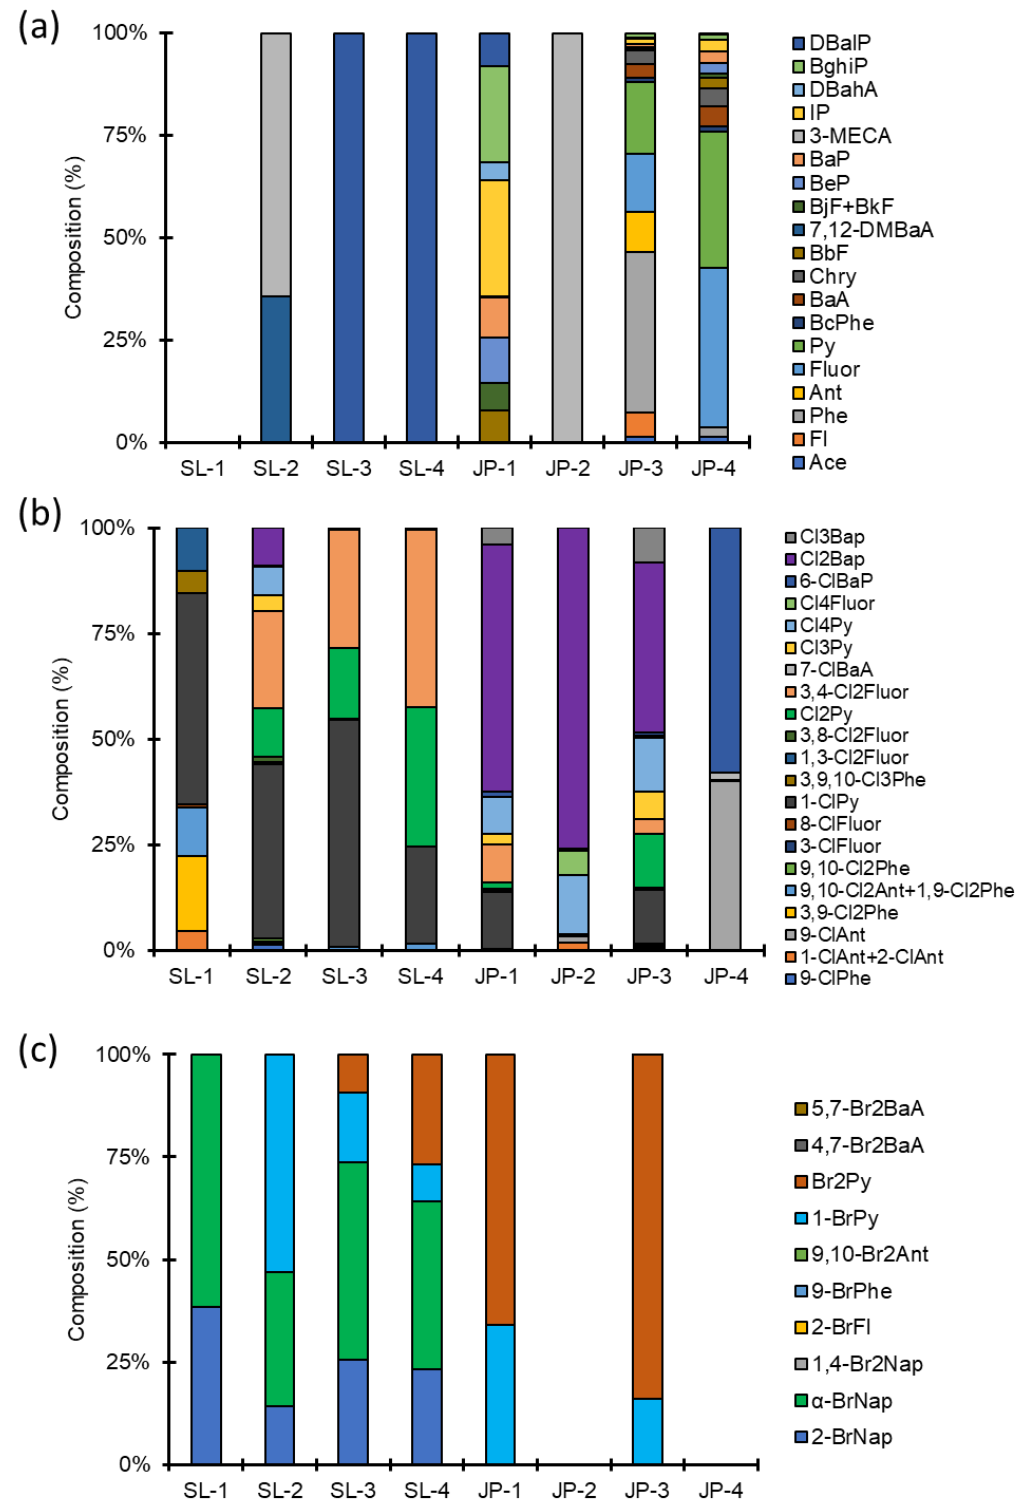
Figure 2. Congener-composition of ( a ) PAHs, ( b ) ClPAHs, and ( c ) BrPAH in milk powder samples from Sri Lanka and Japan.